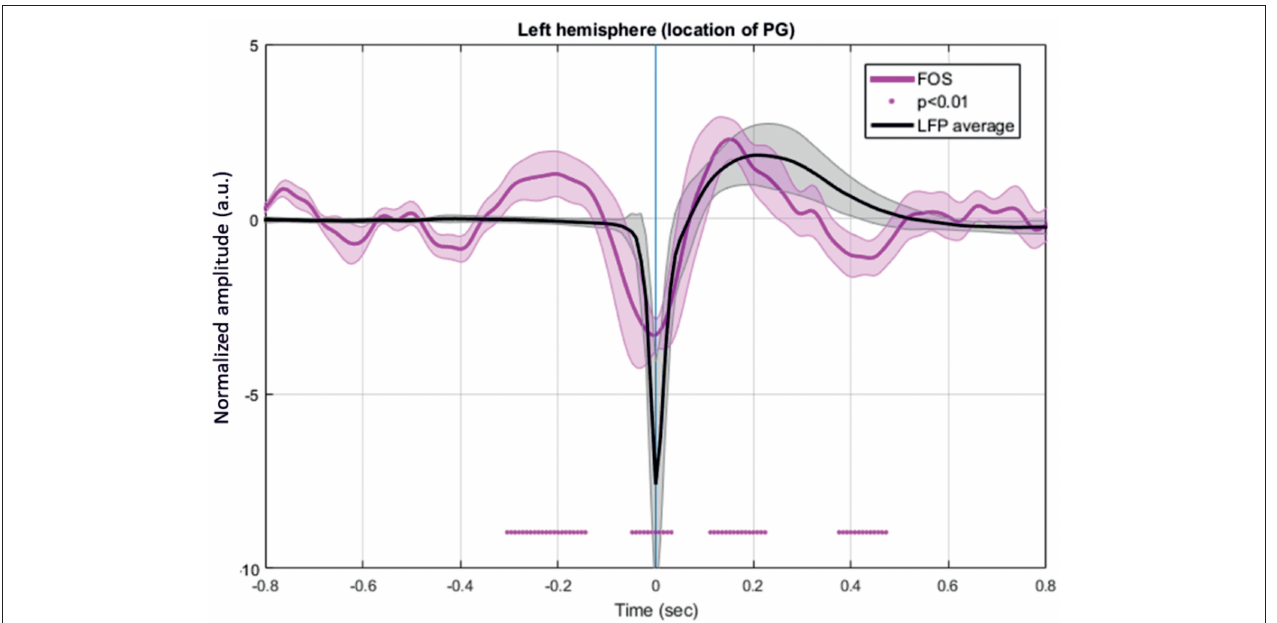
FIGURE 11 | Grand-average of FOS for six rats. The red bar indicates the significant differences from baseline ( − 800 to − 600ms) ( p < 0.05). Note the swing between increase-decrease-increase in light scattering during the simultaneously recorded LFP. Changes in light scattering preceded any changes in LFP by 400ms.